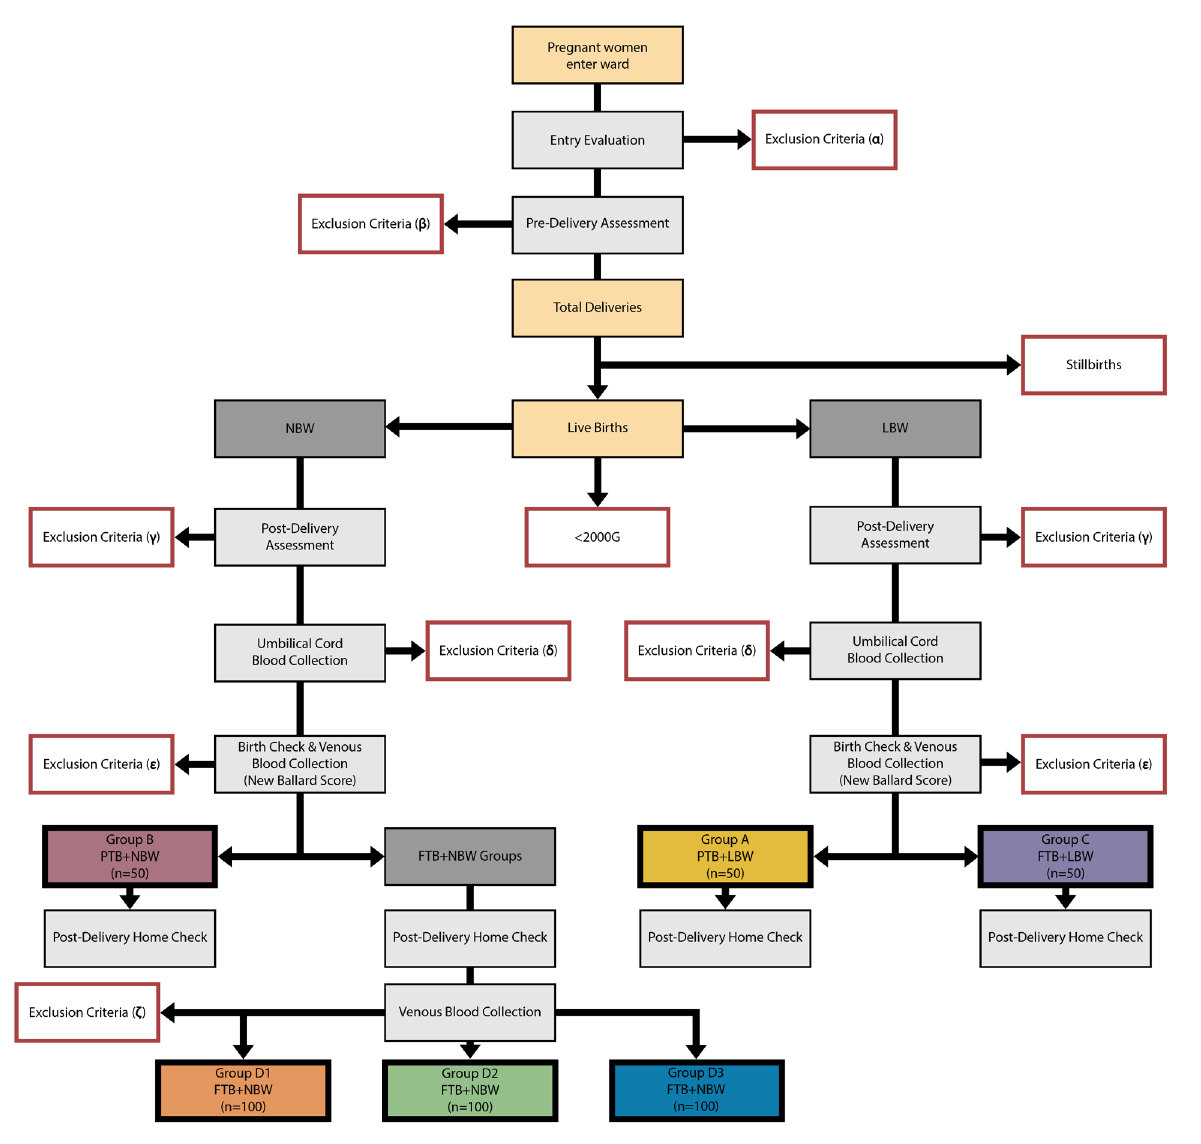
Figure 1. Main study flow chart of all study procedures and exclusion criteria. Group A will contain neonates characterised by preterm birth and low birthweight (PTB+LBW); Group B will contain neonates characterised by preterm birth and normal birthweight (PTB+NBW); Group C will contain neonates characterised by full term birth and low birthweight (FTB+LBW); Groups D1, D2 and D3 will all contain babies characterised by full term birth and normal birthweight (FTB+NBW). In this study, preterm is defined <37 weeks gestation and